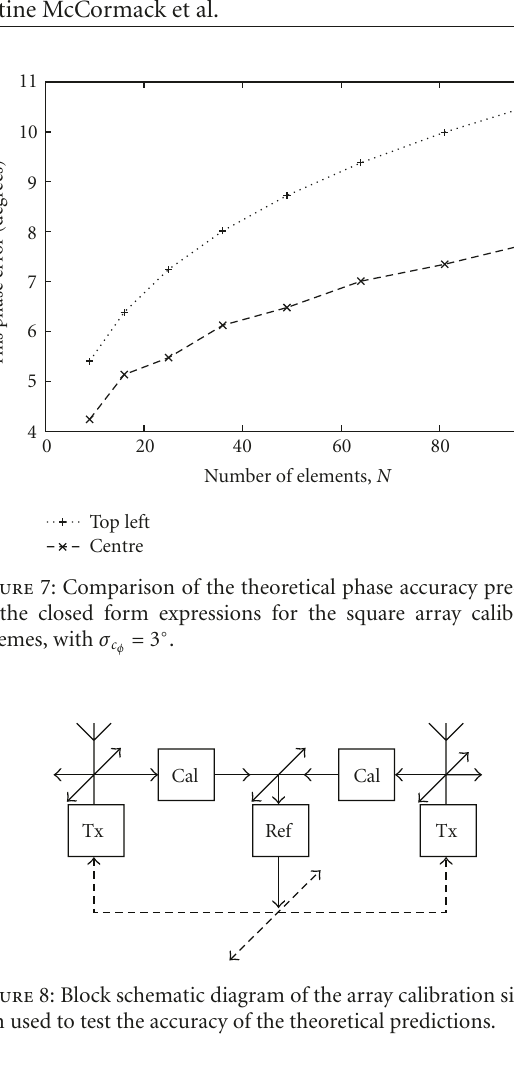
Figure 8: Block schematic diagram of the array calibration simula- tion used to test the accuracy of the theoretical predictions.